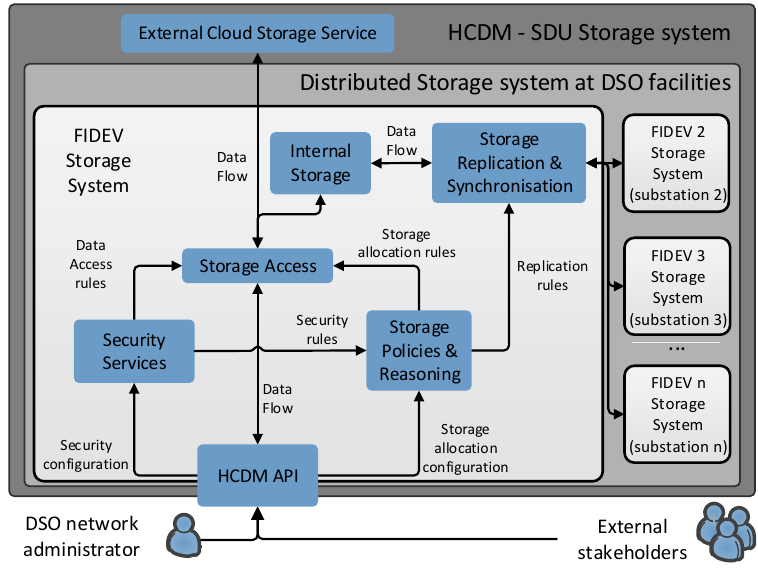
Figure 3. Service composition diagram of the HCDM.